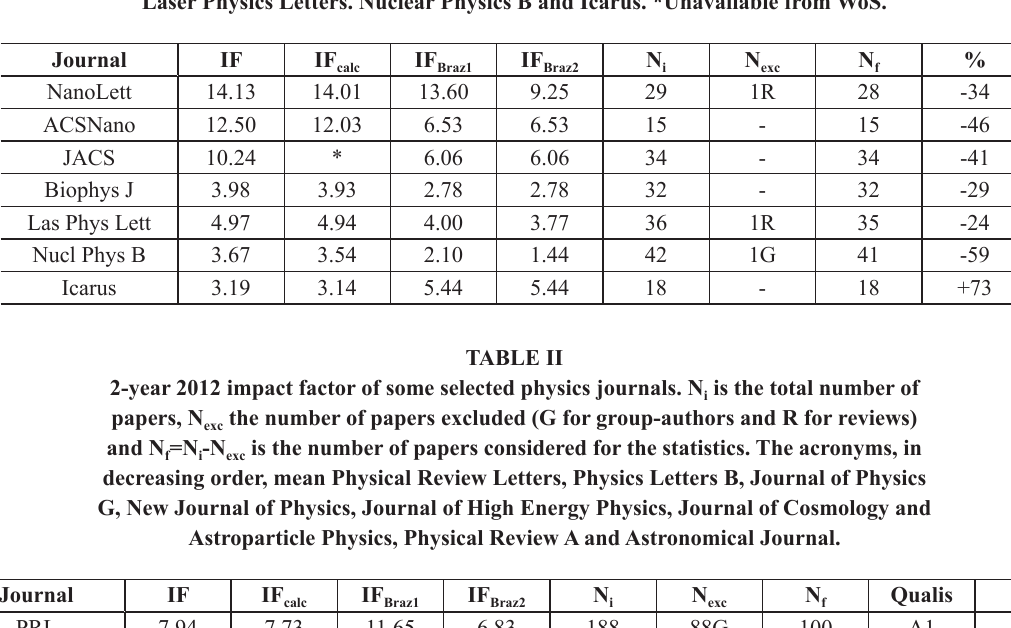
is the total number of papers, i =N -N is f i exc